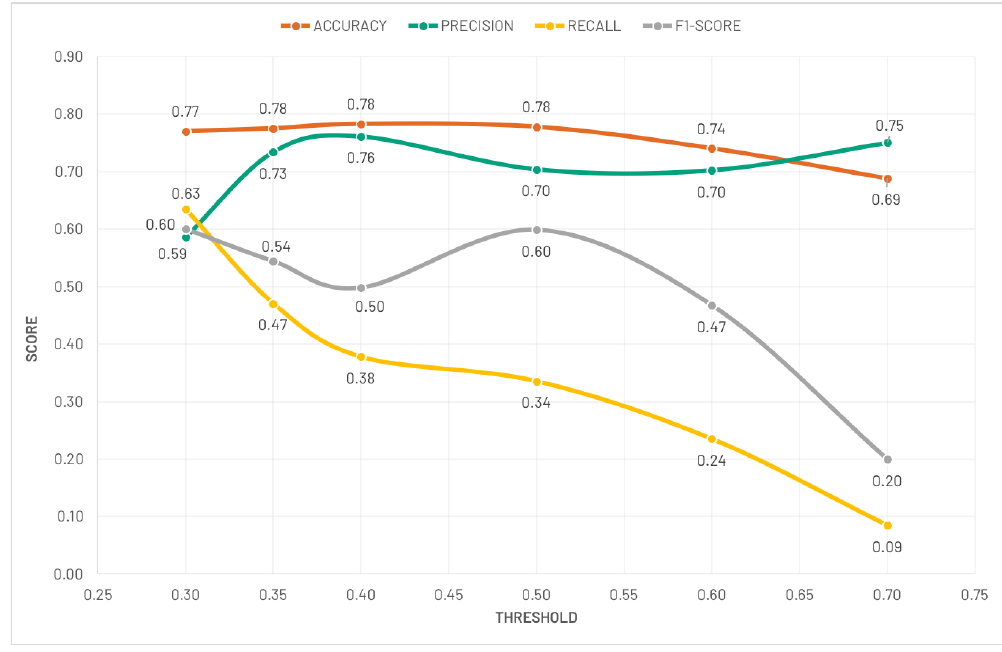
Figure 7. Evaluation metrics. Table 7. Accuracy of the pipeline at different levels of